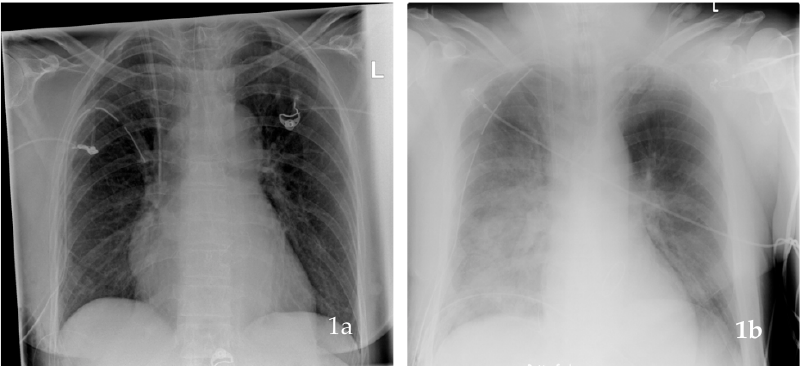
Figure 1. Two chest X-rays at admission to intensive-care-unit after minimal-invasive mitral-valve surgery. ( a ) chest X-ray showing normal lung tissue (no unilateral lung edema), with a chest tube and a central venous line in the upper vena cava. ( b ) chest X-ray of a patient with right sided unilateral pulmonary edema (UPE), i.e., more than 20% opafication of the right hemithorax and a chest tube and a central venous line in